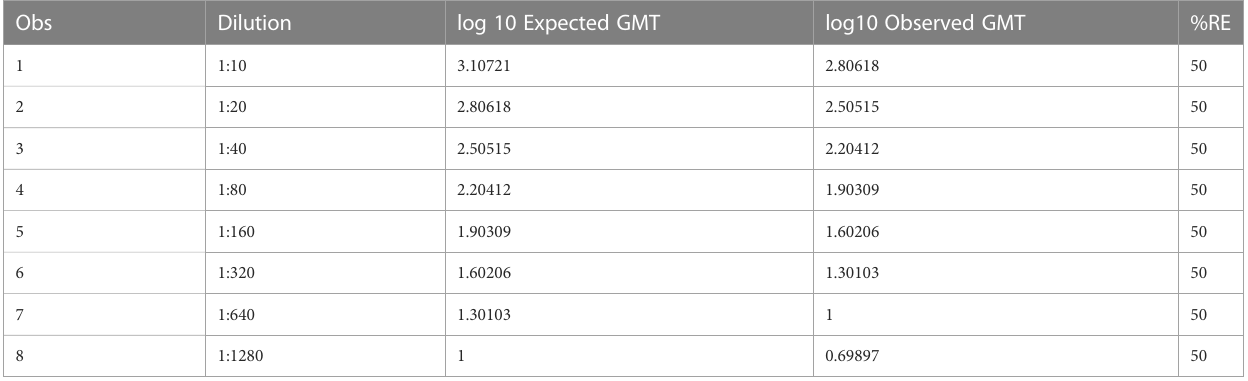
TABLE 6B HAI assay quali fi cation on H3N2 in fl uenza strain A/Texas/71/2017, range testing, accuracy %RE results from linearity assays.